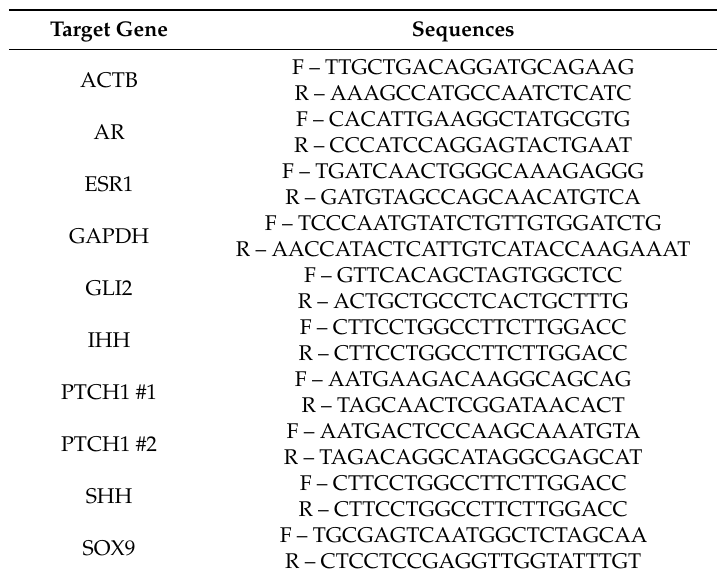
Table 1. Sequences of qPCR primers used in Figure